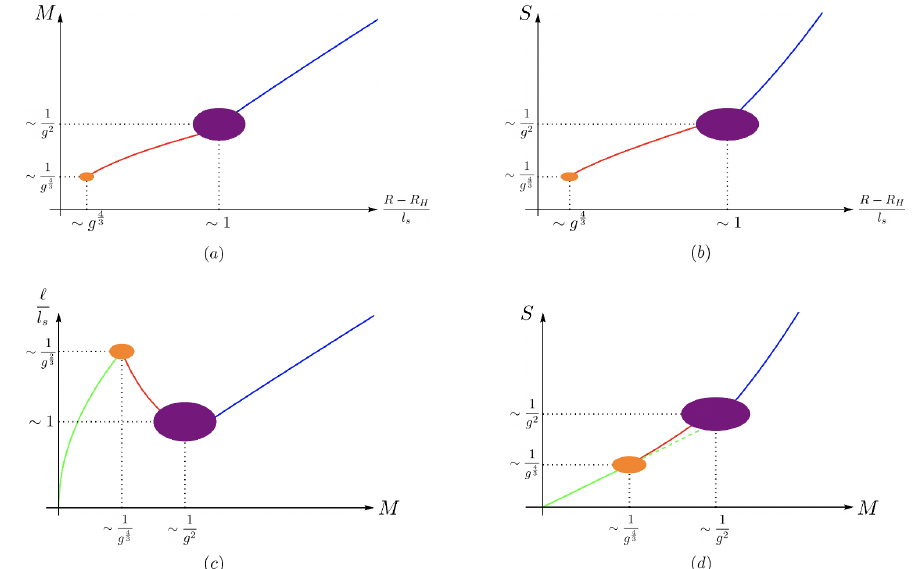
Figure 3 . The phase diagrams for d = 3 . In the plots, the blue, red, green lines represent the black hole, Horowitz-Polchinski solution and free strings, respectively. The orange and purple blobs denote the transition regions between the solutions. In (d), we note that the entropy of the Horowitz-Polchinski solution increases relative to the extrapolation of the free string result (represented by the green dashed line), see